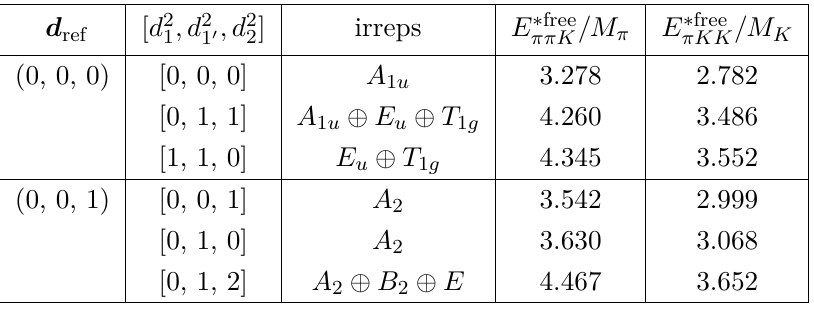
q E 2 − P 2 , and little group irreps, for the free = p 2 ( L/ (2 π )) 2 . The flavor 1 1